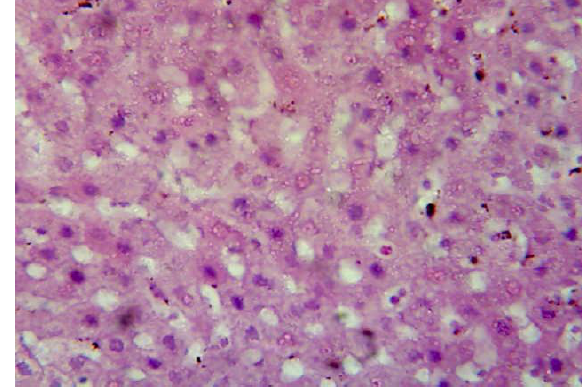
Figure, 8. In section of histopathology in the liver of rat receiving 250mg/kg B.W. of betaine for 65 days in (G2 group): showed normal structure (H.& E.stain 400X).